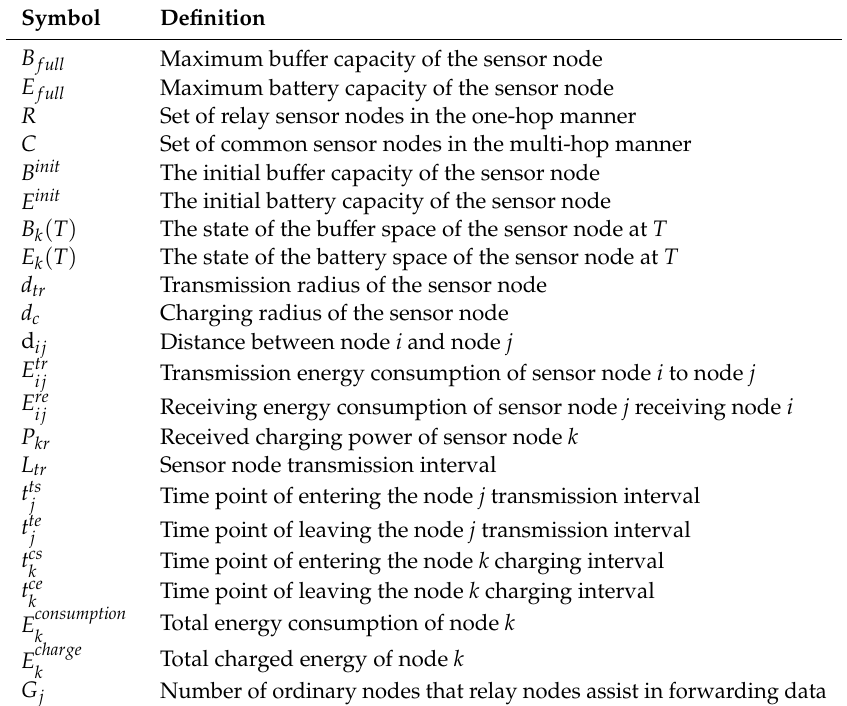
Table 1. Symbols and